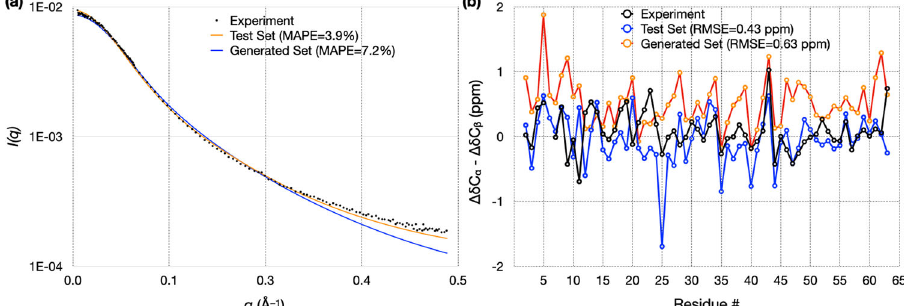
Fig. 7 Validation of autoencoder-generated conformations for ChiZ by experimental SAXS and chemical shift data. a Comparison of experimental and calculated SAXS pro fi les. MAPE was calculated as < j O i (cid:2) E i j = E i > all data points (cid:3) 100 % , where E i and O i are experimental and predicted scattering intensities, respectively, and < (cid:3)(cid:3)(cid:3) > denotes the average over all the data points. b Comparison of experimental and calculated secondary chemical shifts. all data points The experimental data and the MD simulations are reported previously 14 . RMSE was calculated as the square root of < ð O i (cid:2) E i Þ 2 > all data points . Calculations were done on either the test set comprising 12,180 conformations sampled from 12 MD runs, or on an autoencoder-generated set comprising the same number of conformations, after re fi nement. The autoencoder was trained on a combined training set comprising 52,200 conformations sampled from the 12 MD